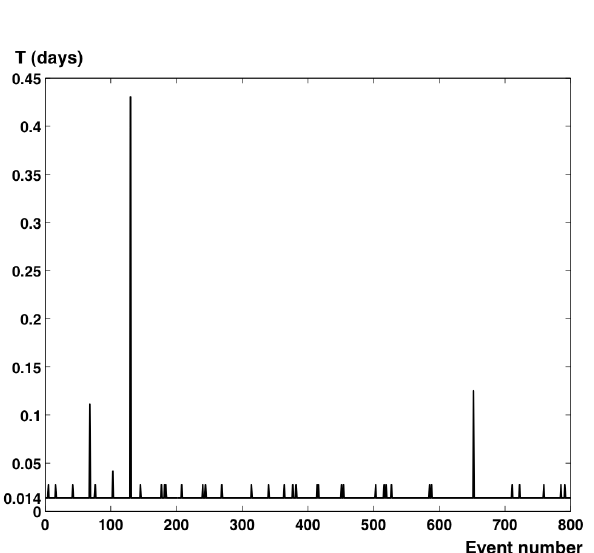
Fig. 4. The probability density function of void intervals for pH series. This shows that many scales are involved. It also shows some local maxima associated with